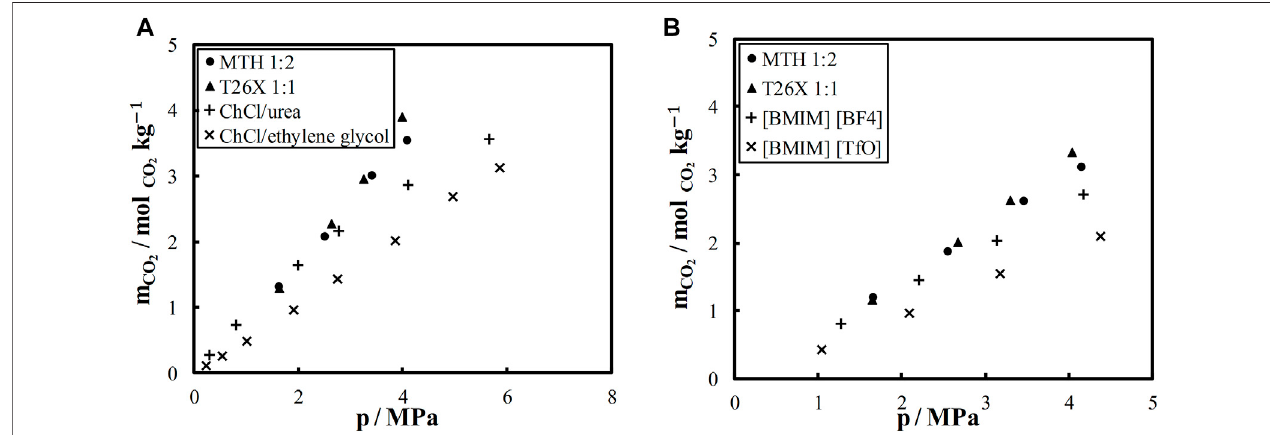
FIGURE3| Carbondioxidesolubility (A) inL-menthol/thymol(MTH),thymol/2,6-xylenol(T26X),cholinechloride(ChCl)/urea(Leronetal.,2013),andChCl/ethylene glycol (Leron and Li, 2013) at 303.15 K (B) and in MTH, T26X (BIMI) (BF4), and (BMIM) (TfO) (Aki et al., 2004) at 313.15 K.